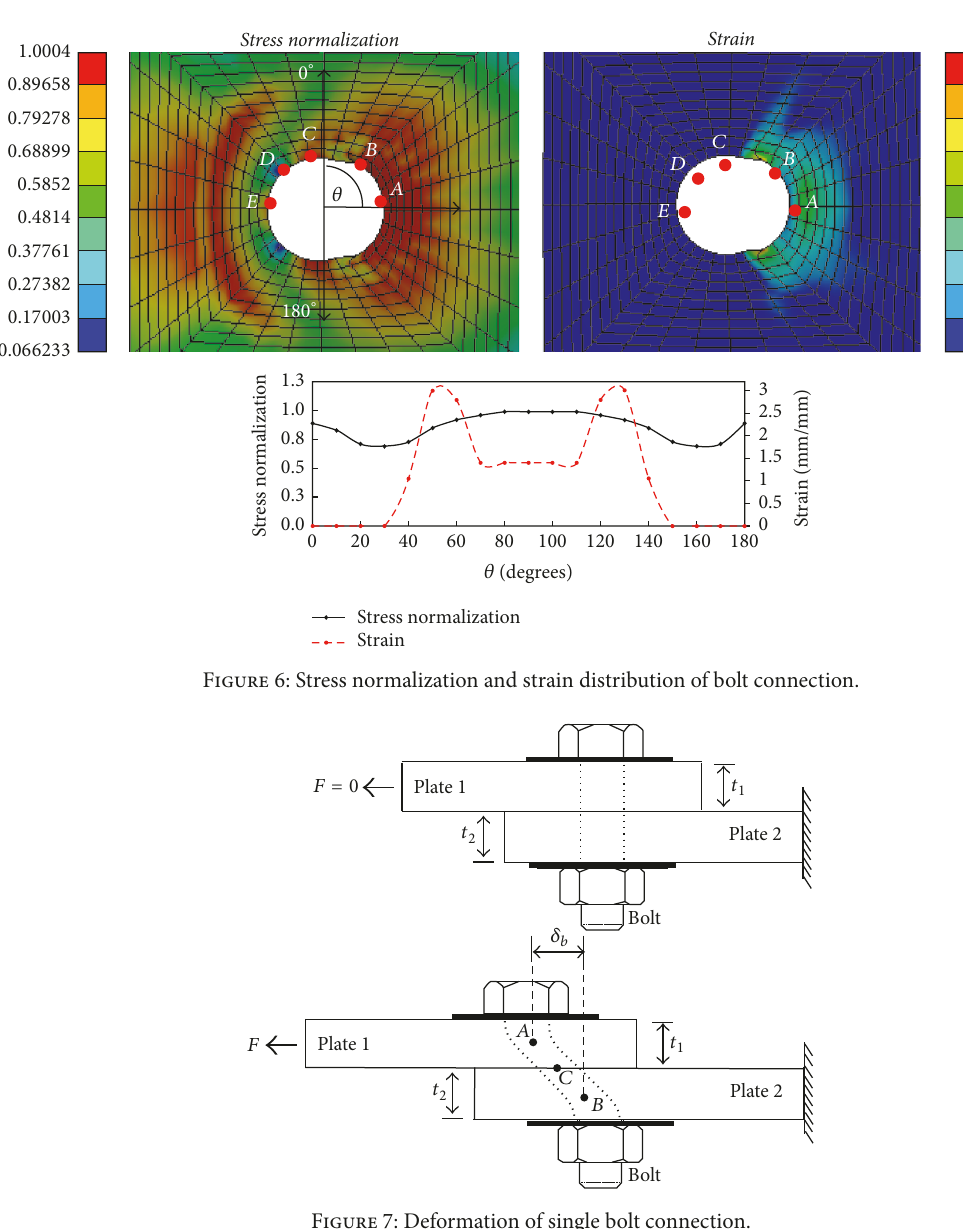
Figure 7: Deformation of single bolt connection.